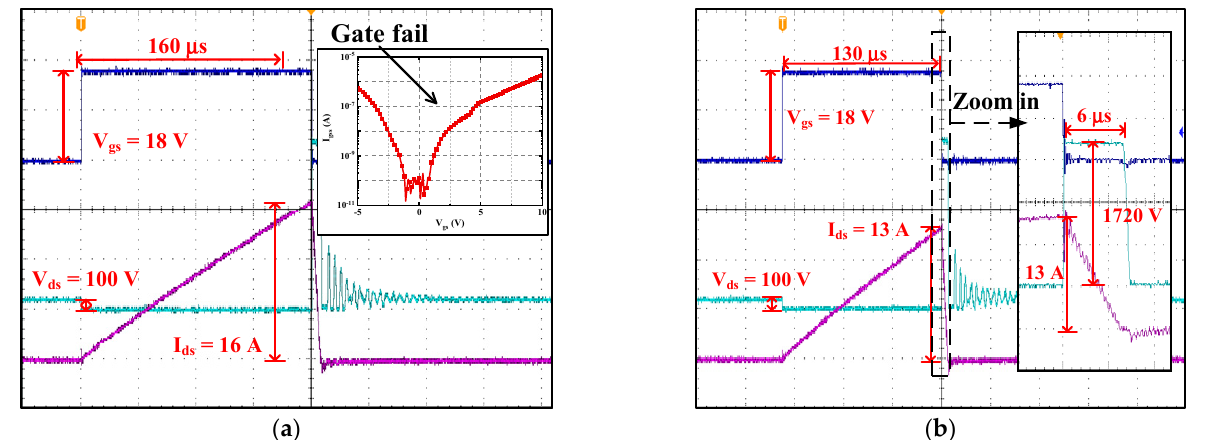
Figure 3. The avalanche waveforms of the double-trench SiC MOSFET. ( a ) The failure waveforms. ( b ) The waveforms adopted to stress the device.